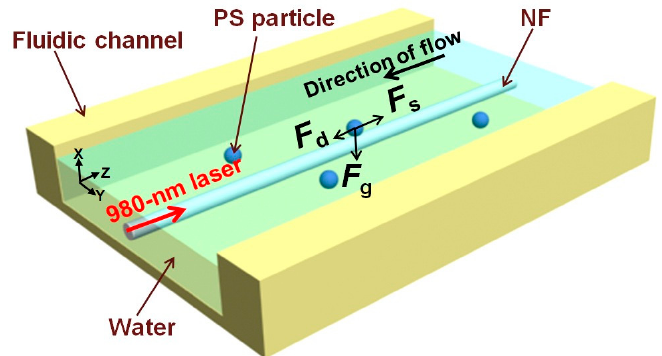
Figure 14. Schematic diagram of the experiment. F d shows the drag force on the particle (in blue) induced by the fluidic flow. F g and F s denote the gradient and scattering forces, respectively, from the evanescent field [68].